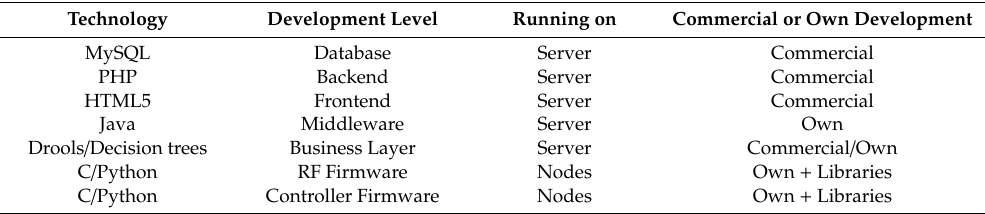
Table 2. SW technologies used in the PLATEM